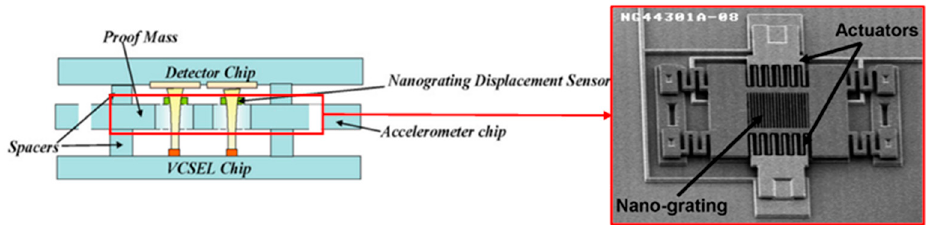
Figure 10. GS-based accelerometer. Reprinted with permission from Ref. [42]. Copyright 2008 Else-